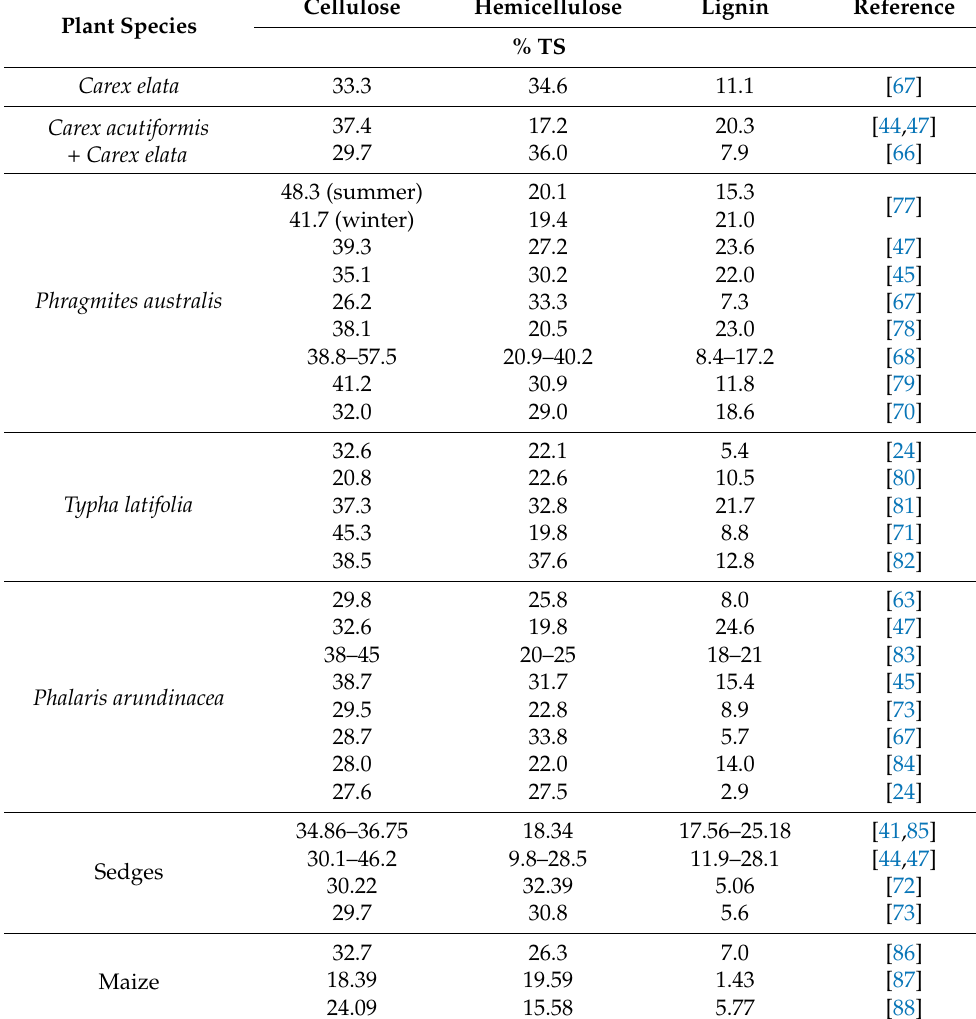
Table 7. Lignocellulose characteristics of wetland plants according to the